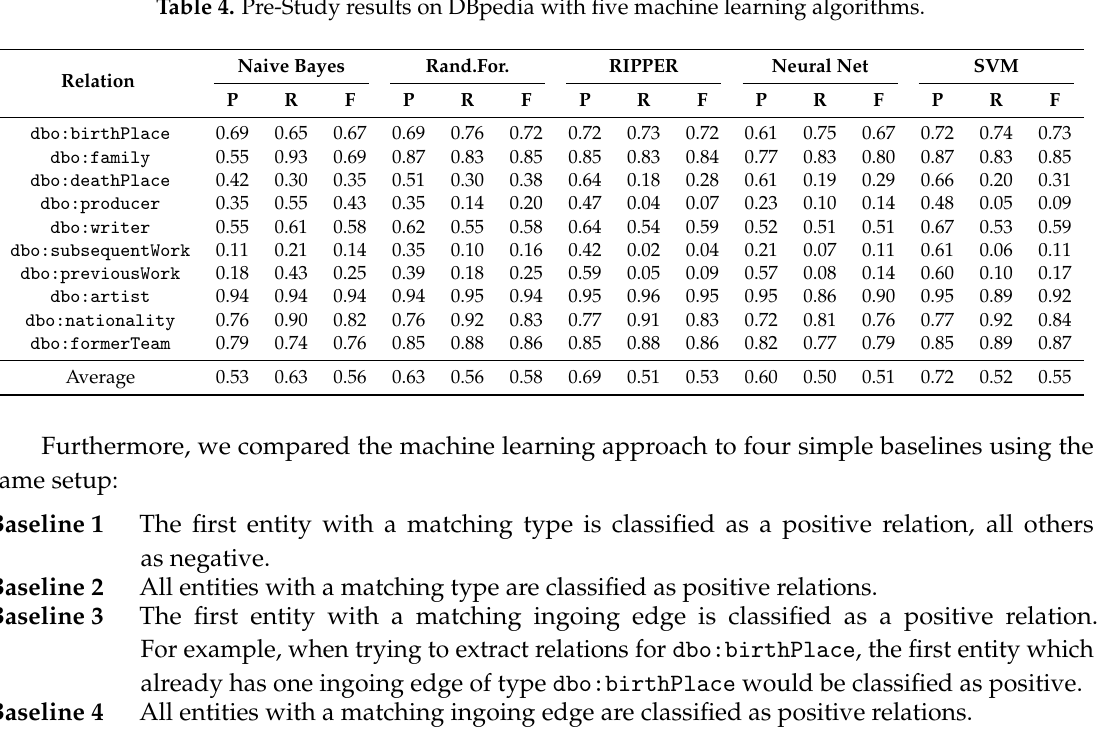
Table 4. Pre-Study results on DBpedia with five machine learning algorithms.